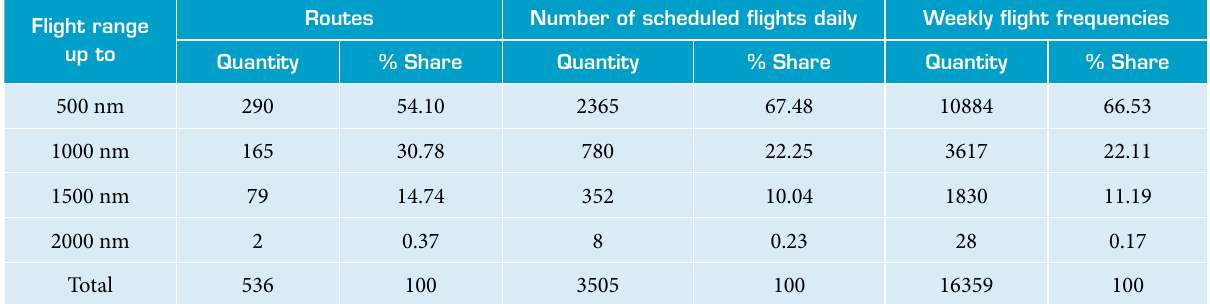
Table 1. Average flight range in